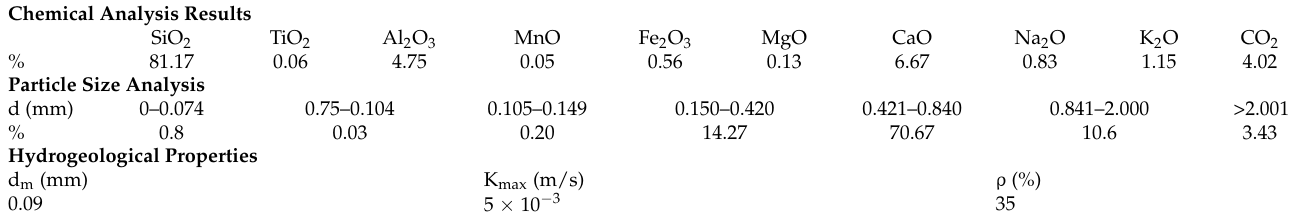
Table 1. Chemical analysis, particle size analysis, hydrogeological